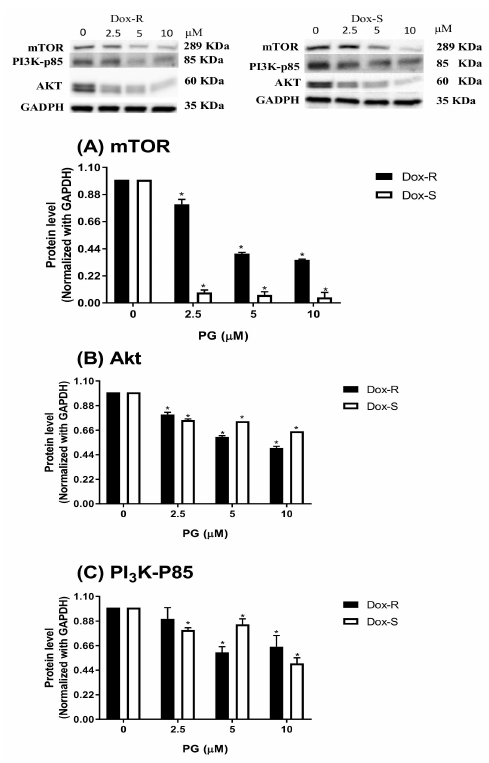
Figure 5. Autophagic inhibitor level change in Dox-R and Dox-S cells after PG treatment. ( A ) mammalian target of rapamycin (mTOR), ( B ) protein kinase B (Akt), and ( C ) phosphatidylinositol-4,5-bisphosphate 3-kinase-p85 (PI3K-p85) protein levels were determined by chemiluminescent Western blotting and normalized with GAPDH. Results were shown as mean ± SD in 3 independent experiments. *, p < 0.05 compared with untreated control.